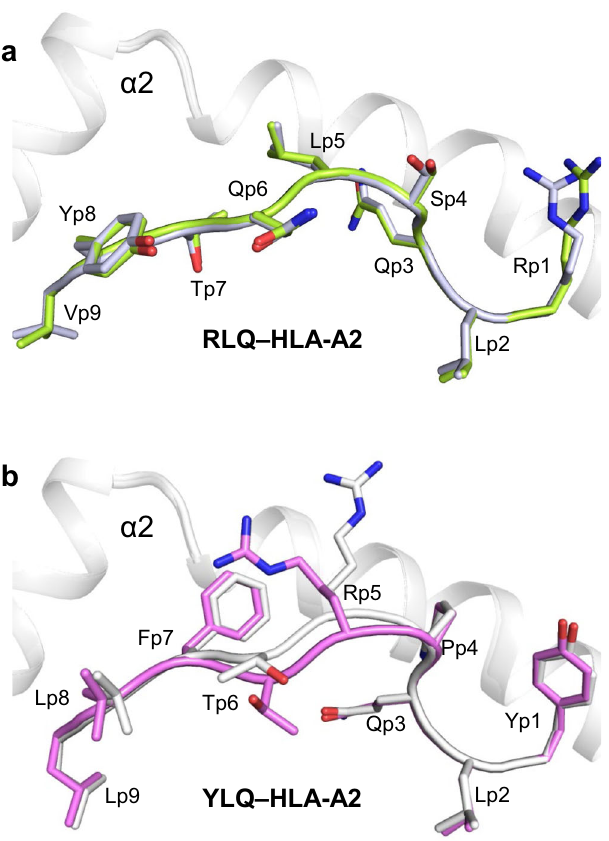
Fig. 3 Conformations of RLQ and YLQ peptides bound to HLA-A2. a Side view of two superposed RLQ – HLA-A2 molecules in the asymmetric unit of the crystal. Carbon atoms of the superposed RLQ peptides are light green or gray; nitrogen atoms are blue; oxygen atoms are red. HLA-A2 is gray. Residue labels for RLQ are aligned with the α -carbon atom of the respective residue. b Side view of two superposed YLQ – HLA-A2 molecules in the asymmetric unit of the crystal. Carbon atoms of the superposed YLQ peptides are violet or